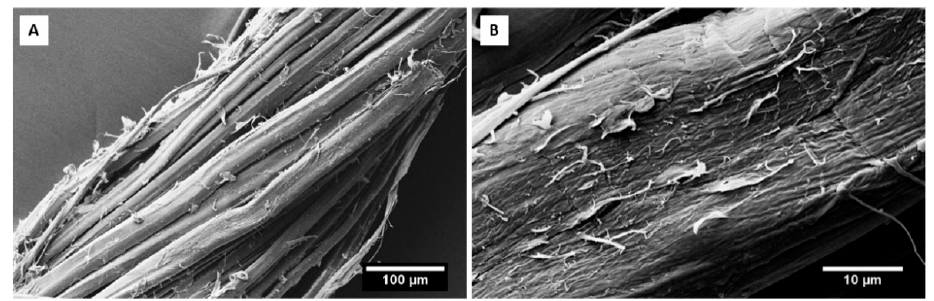
Figure 2. SEM micrographs showing the supercritical CO 2 treated flax yarn ( A ) and a detail of the flax fiber surface ( B ).